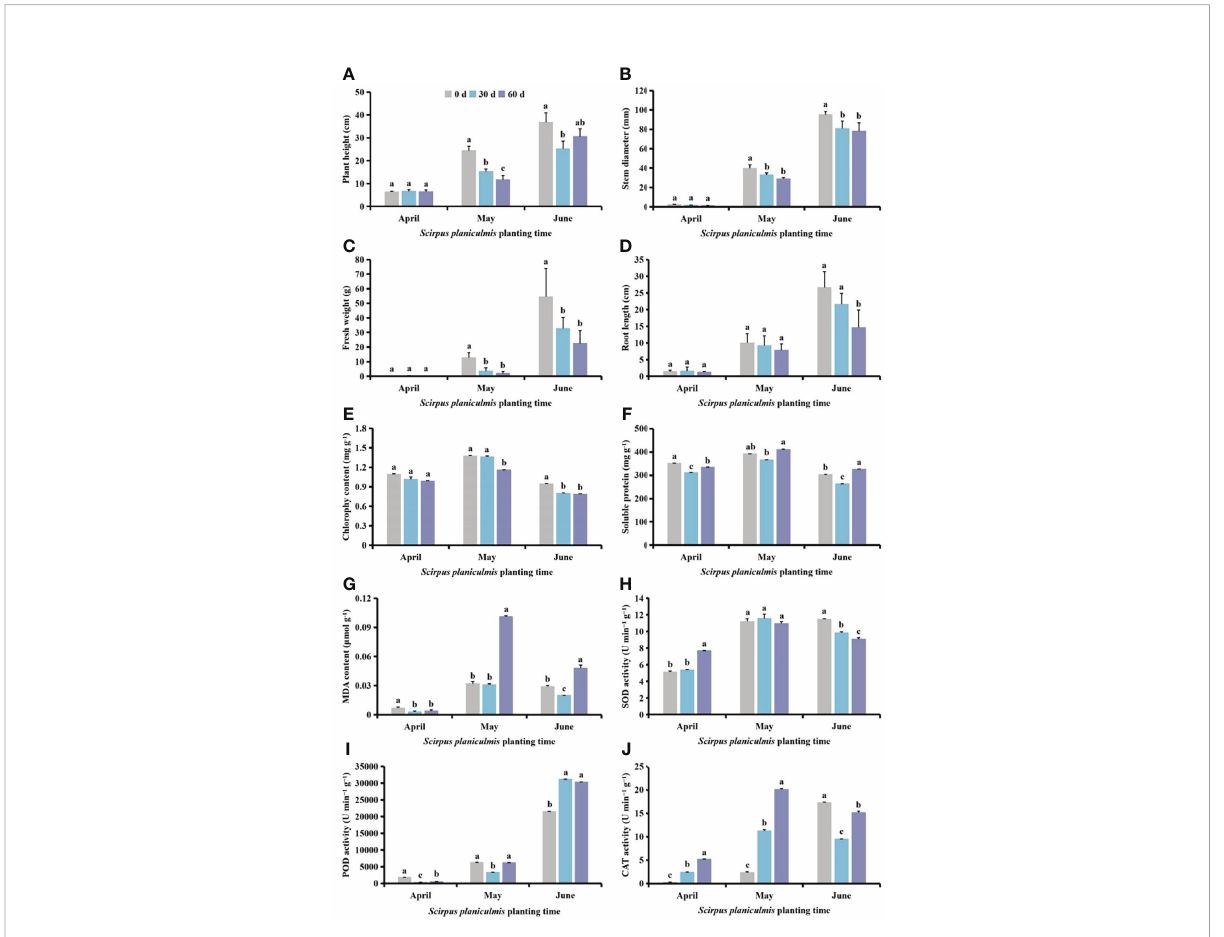
FIGURE 6 Under different Scirpus planiculmis planting time, the (A) plant height, (B) stem diameter, (C) fresh weight, (D) root length, (E) chlorophyll, (F) soluble protein and (G) malondialdehyde (MDA) content, and (H) superoxide dismutase (SOD), (I) peroxidase (POD) and (J) catalase (CAT) activities in cotton at different competition periods The mean value ± standard data were presented in the fi gure. Different alphabetical letters indicate the signi fi cant differences between different competition periods ( p